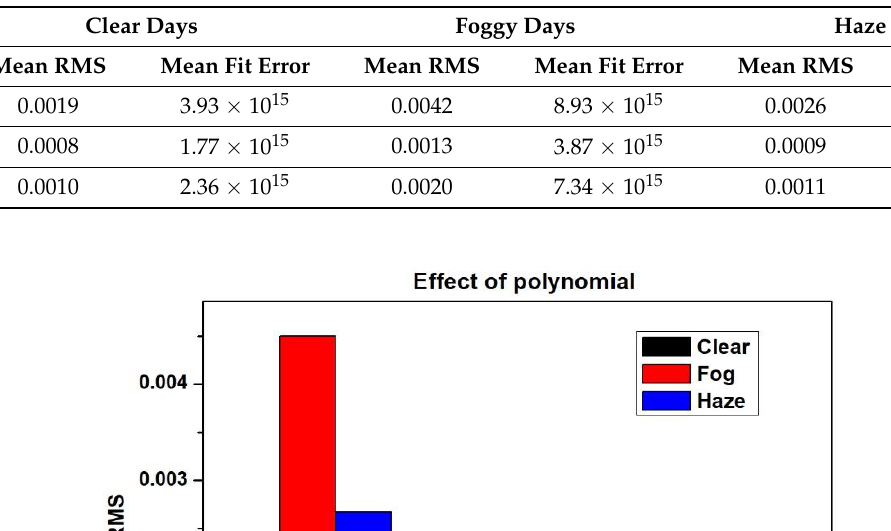
Table 4. Mean RMS and mean fit error at different fitting windows during different meteorological conditions. Fitting Window